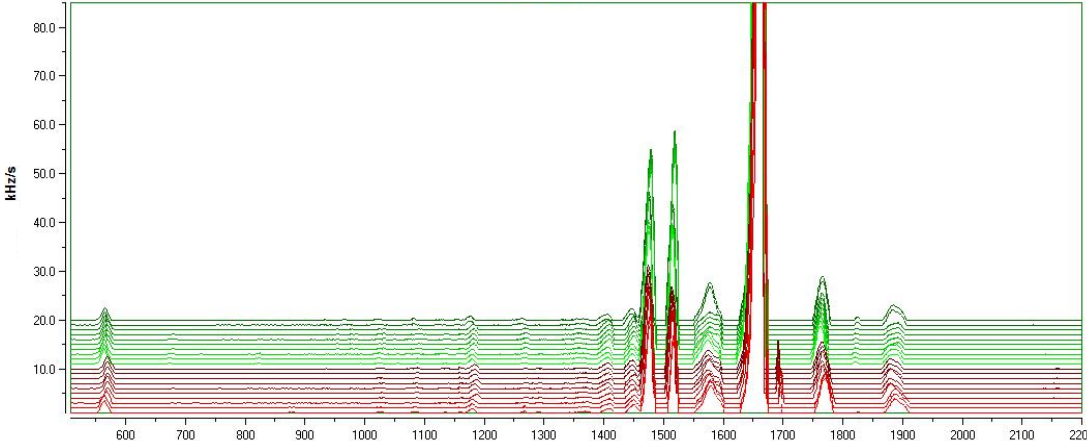
Figure 2. GC-SAW chromatograms of 20 turmeric samples (from top to bottom are turmeric samples numbers 1–20).